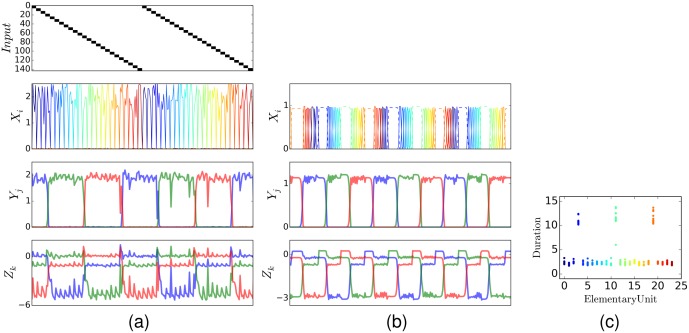
Input and network activities during learning and recall.
s
k, x
i, y
j, z
k during learning (after 5 presentations) (a) and during sequence recall (after 120 presentations) (b). Within each layer, different colors represent different modes (variables). The sensory input (presented only during learning) consisted of 24 different patterns presented sequentially. The patterns were composed of 144 binary (represented in black and white) pixels. During learning, the input drives the system dynamics. During recall, the elementary modes and the chunking modes activate in the same order as in learning. Each CM represents about 8 consecutively active elementary modes. The onset of each chunk is delayed and caused by the inhibition from the chunking layer. It is consistent with pauses before loading chunks observed in behavioral studies (highlighted in dashed line). (c) Duration that each EM remains active, with the same color codings as in (b). Three modes associated to the transitions between chunks remain active for a longer time than the others. Such pauses can be identified with pauses observed in behavioral experiments involving chunking [17].